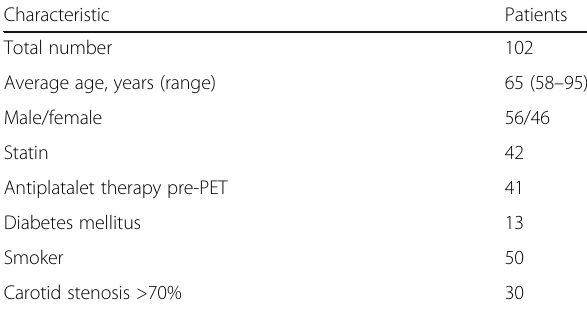
Table 1 Clinical characteristics of patients